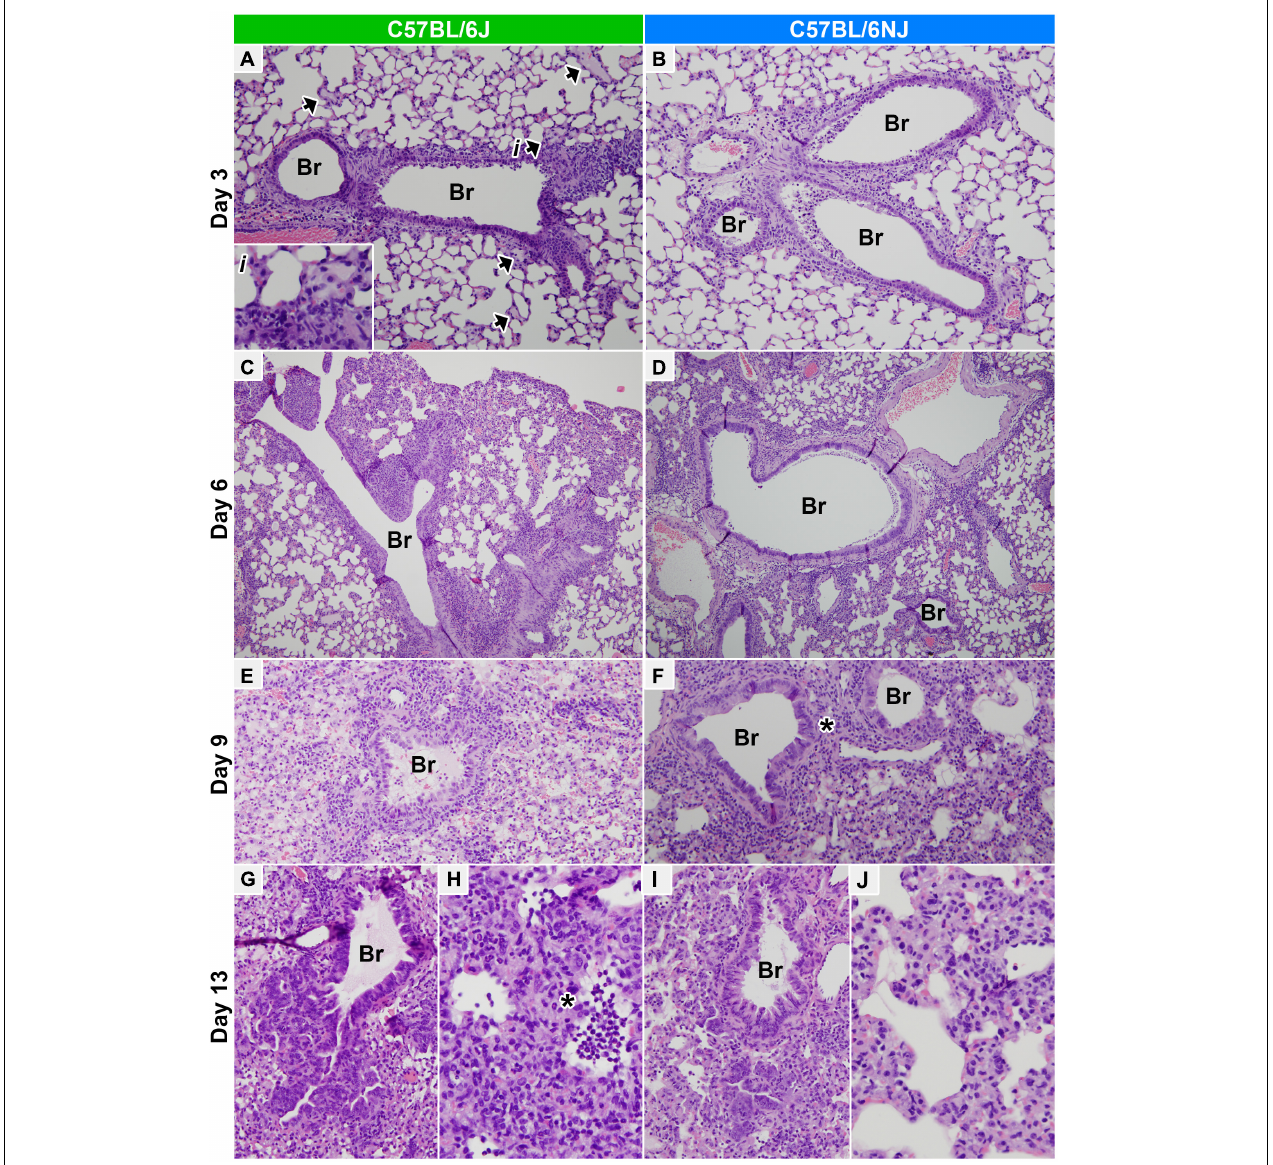
FIGURE 4 | Lung histopathology. Hematoxylin and eosin stained lung tissue sections from CA04-infected C57BL/6J (A,C,E,G,H) or C57BL/6NJ (B,D,F,I,J) mice. (A,B) Medium bronchioles and adjacent alveolar parenchyma on day 3 post-infection (100 × magnification). Necrotizing bronchiolitis is prominent in both C57BL/6J and C57BL/6NJ mice, but acute alveolar damage and edema in the parenchyma abutting affected airways are more pronounced in C57BL/6J mice [see the arrowheads and inset (i) in A ]. (C,D) Large bronchioles and adjacent alveolar parenchyma on day 6 post-infection (40 × magnification). Lungs of C57BL/6J and C57BL/6NJ mice are similar, with necrotizing bronchiolitis slightly less severe than day 3, and locally severe to regionally extensive peribronchiolar and subpleural alveolar damage and pneumonia. (E,F) Small bronchioles and adjacent alveolar parenchyma on day 9 post-infection (100 × magnification, with 3.5-fold enlargement). Interstitial pneumonia and diffuse alveolar damage are widespread both C57BL/6J and C57BL/6NJ mice, with slightly more extensive alveolar disease in C57BL/6J mice. Regions of prominent segmental bronchiolar epithelial hyperplasia occur in both strains, but are more prominent in C57BL/6NJ mice [see asterisk ( ∗ ) in F ]. (G,I) Terminal bronchioles and adjacent alveolar parenchyma on day 13 post-infection (100 × magnification, with threefold enlargement). Many small and terminal airways exhibit prominent, deeply basophilic hyperplastic columnar epithelium which extends into adjacent alveoli. (H,J) Alveolar parenchyma on day 13 post-infection (200 × magnification, with threefold enlargement). Alveolar necrosis is more prominent in C57BL/6J mice [see asterisk ( ∗ ) in H ]. See Supplementary Table S1 for all histopathology scoring data. Br, bronchi/ioles.